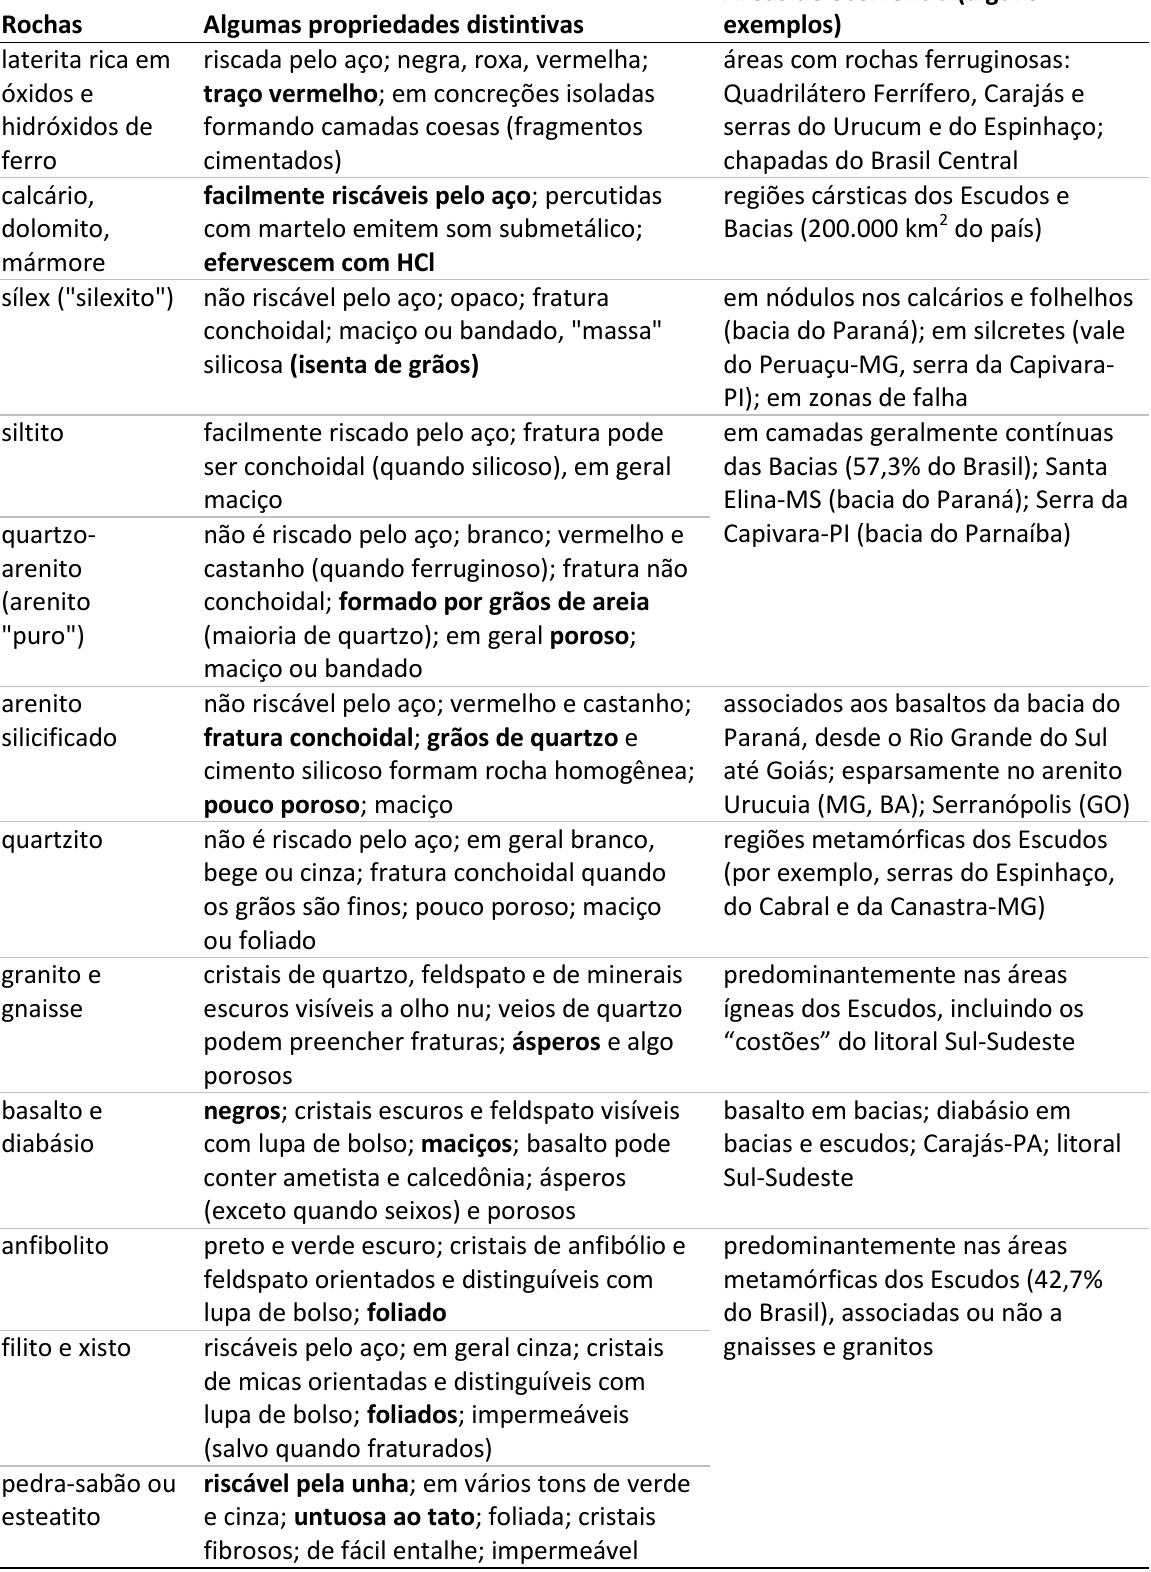
Table 4. General criteria to field recognizing of the main Brazilian rocks. Main sources: Suguio (1980), Sgarbi (2007), Williams et al. (1970), IBGE (1999), Winge